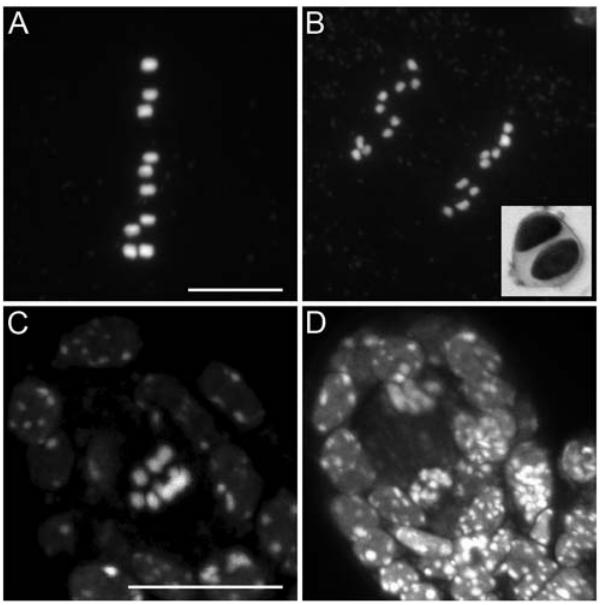
Figure 6. Mitosis-like divisions instead of meiosis in MiMe plants. (A) Male metaphase I (B) Male anaphase I. The vignette shows a dyad in MiMe . (C) Female metaphase I. (D) Female anaphase I. Scale bar=10 m m.